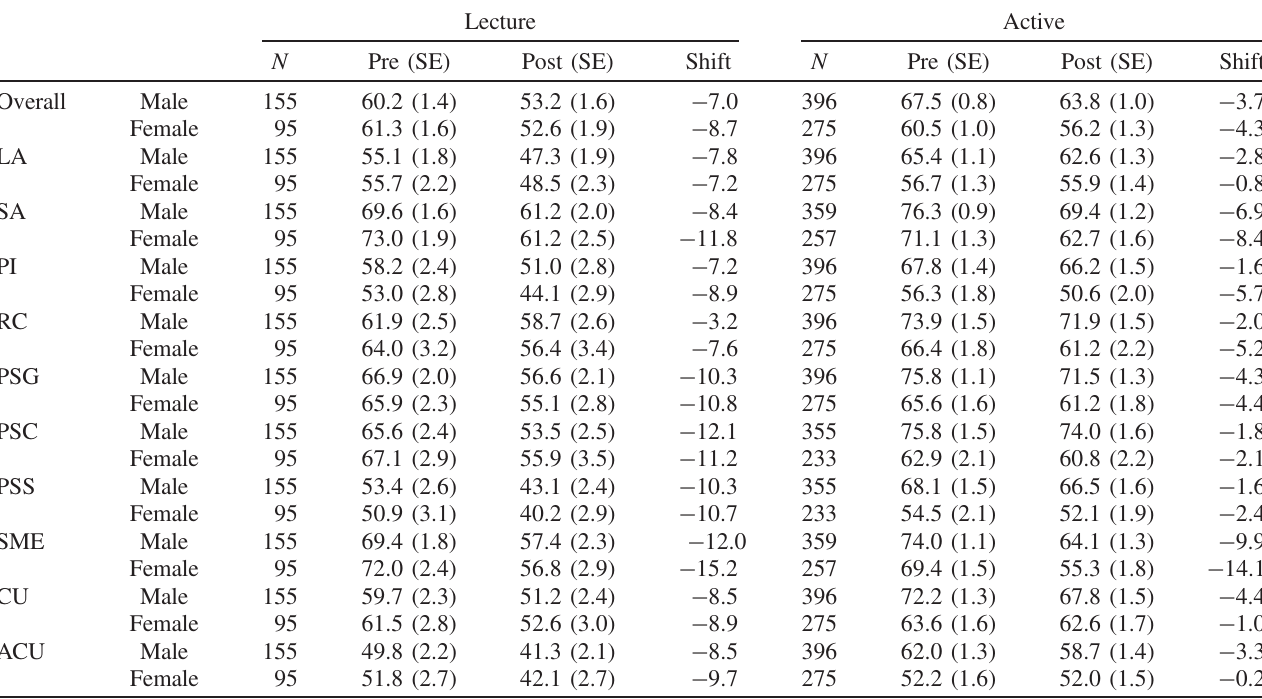
TABLE X. Detailed descriptive statistics among males and females for the whole-year CLASS. SE indicates Standard error.